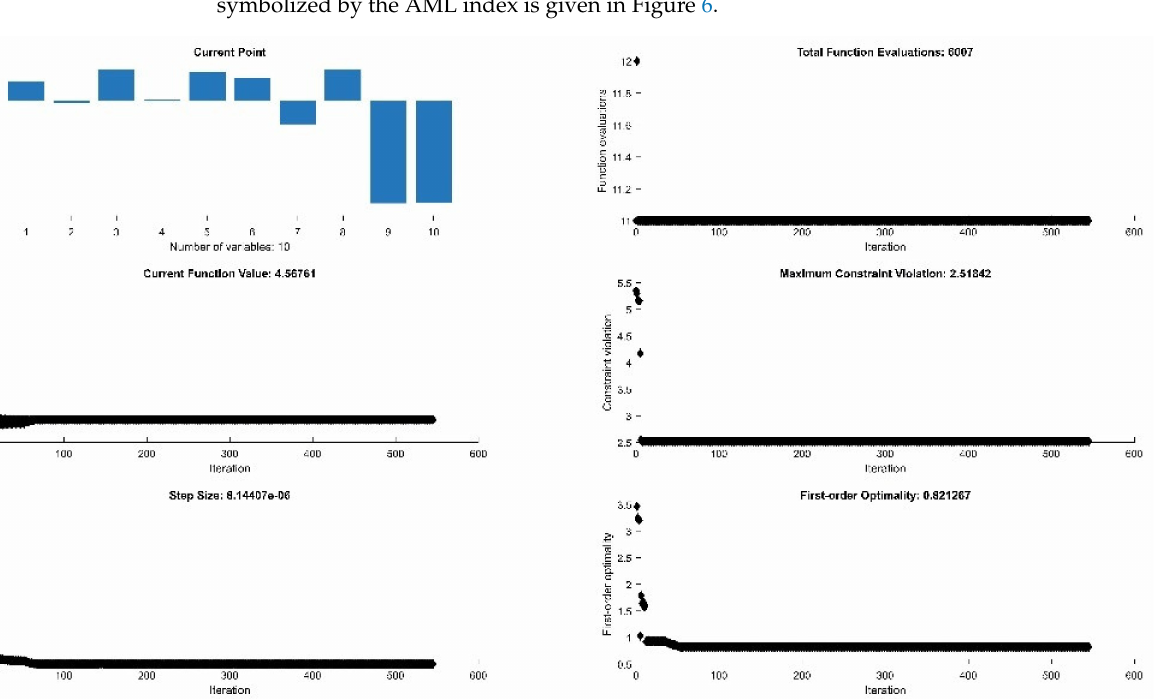
Figure 6. Graphical outputs of the optimization procedure. Source: Compiled by the authors using